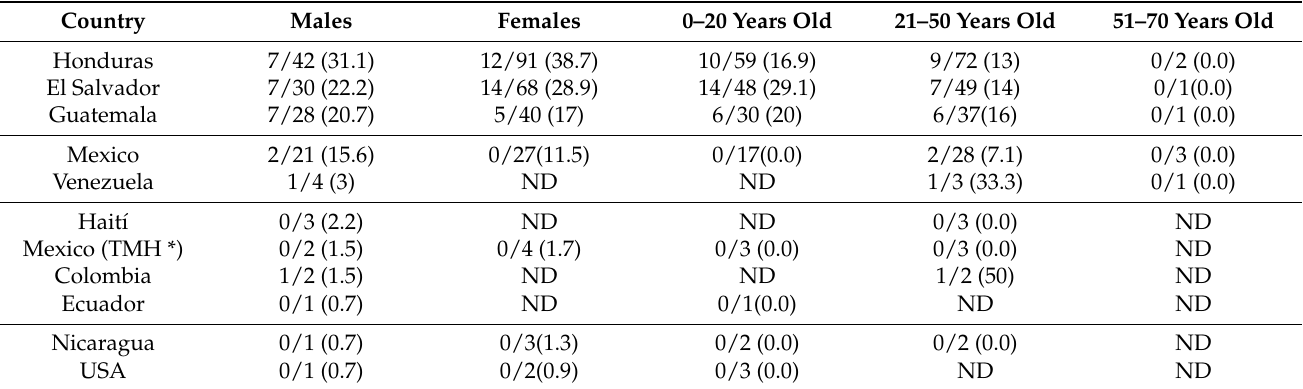
Table 2. Testing results (no. of positives/no. of examined) for SARS-CoV-2 antigen in nasopharyngeal swabs of migrants arriving to “The Migrant House” in Reynosa, Mexico, according to country of origin, gender, and age group.